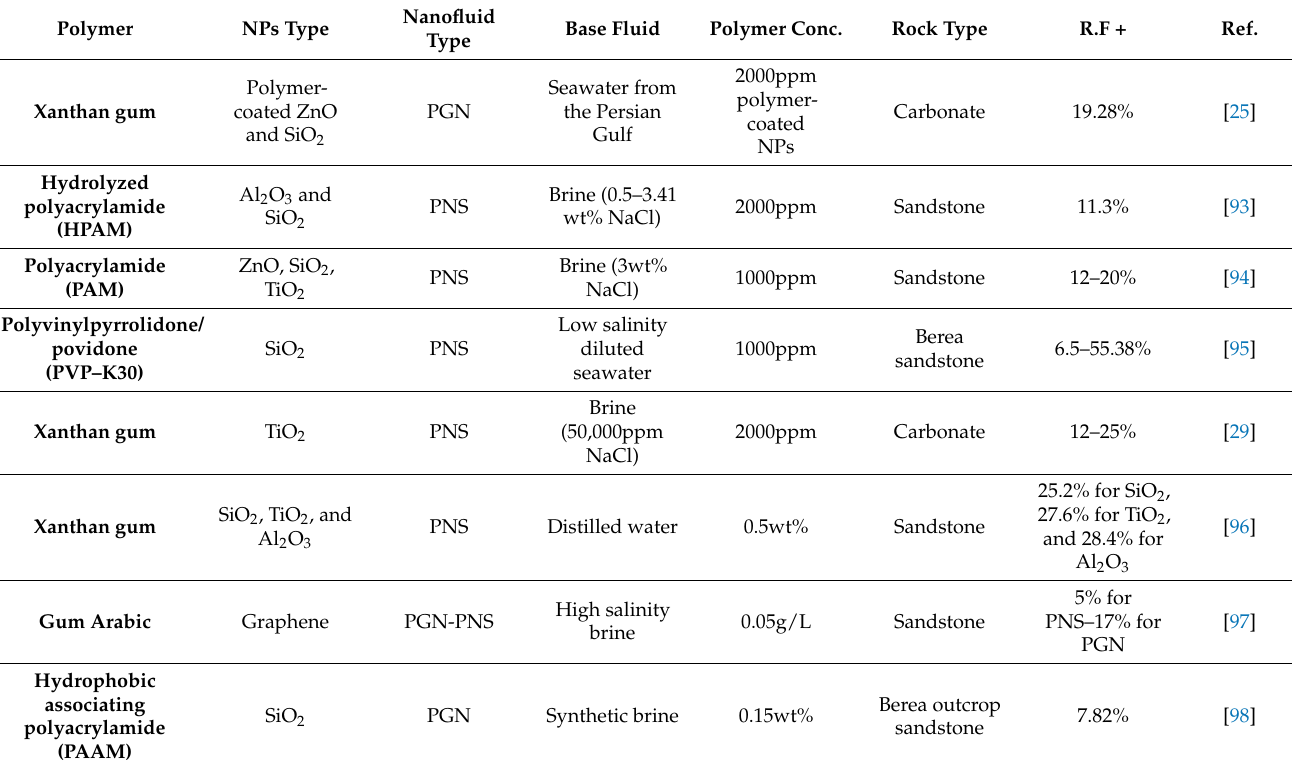
Table 3. Recent studies on polymer nanofluids application in